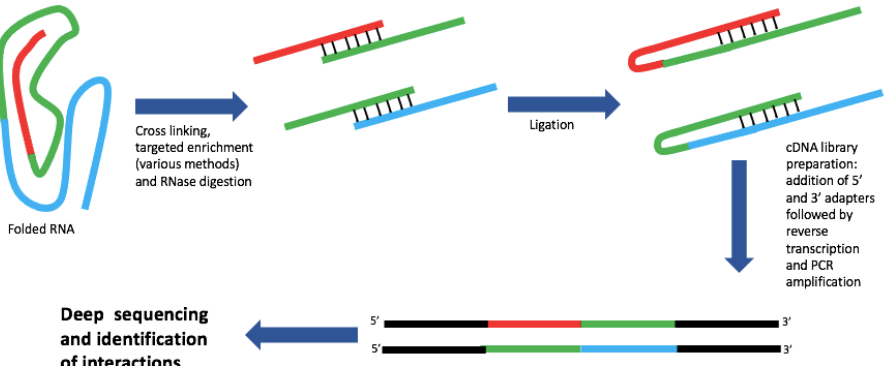
Figure 3. Process diagram for proximity ligation. Although the specifics of different proximity ligation methods vary, many follow the general scheme shown above. The modular nature of the scheme allows a mixing and matching of different steps to suit the experimental goals. Table 2. Proximity ligation techniques .